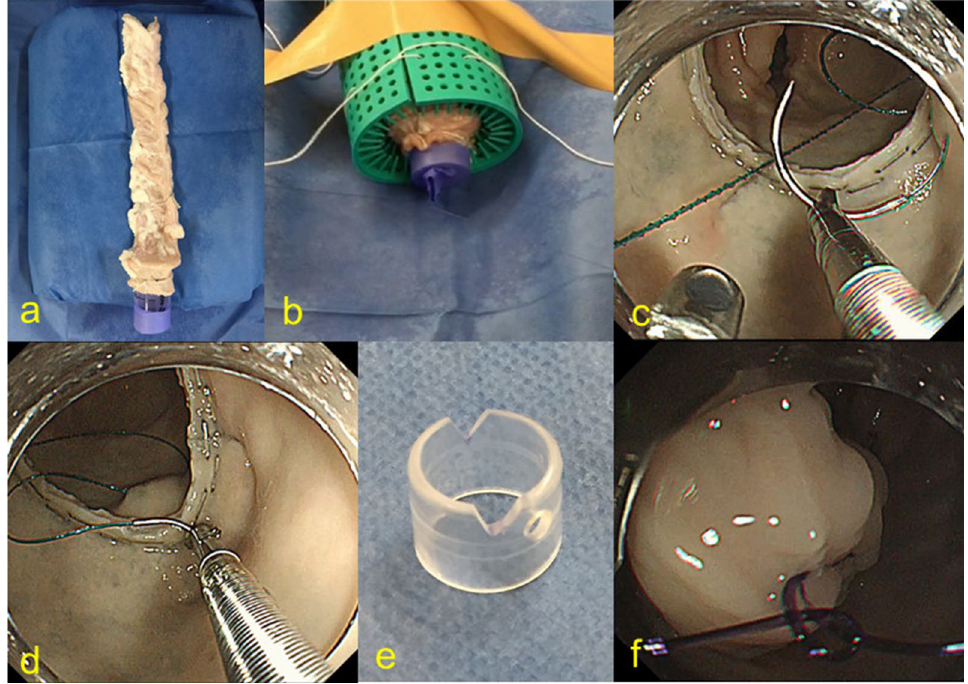
Figure 1. Endoscopic hand suturing for rectal anastomosis. ( a ) A porcine rectal model with anastomosis which is made with double stapling technique. ( b ) The rectal model having a virtual anus is fixed on a rubber roll with string. ( c, d ) The full layer at the proximal side of the anastomosis is sutured using a flexible needle holder ( c ), followed by suturing at the distal side ( d ). ( e ) In nodule suturing, a notched transparent straight hood is used. ( f ) A extracorporeally-created knot is delivered to the anastomotic site using the